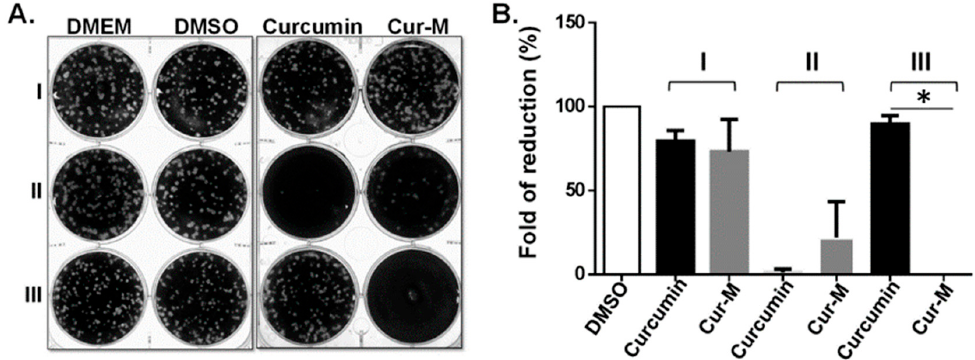
Figure 4. Curcumin-loaded self-assembled micelles (Cur-M) exerted potent, but distinct, anti-influenza activity. MDCK cells were treated with Dulbecco’s modified eagle’s medium (DMEM, mock control), DMSO (solvent control), curcumin, or Cur-M at various times of influenza A virus (IAV) infection (100 pfu), including pre-treatment (I), co-treatment (II), or post-entry treatment (III). The effect on the plaque-forming ability (infectivity) is shown ( A ), and the results from three independent experiments are plotted ( B ). Statistically significant differences compared with the native curcumin group are indicated by * ( p < 0.05).